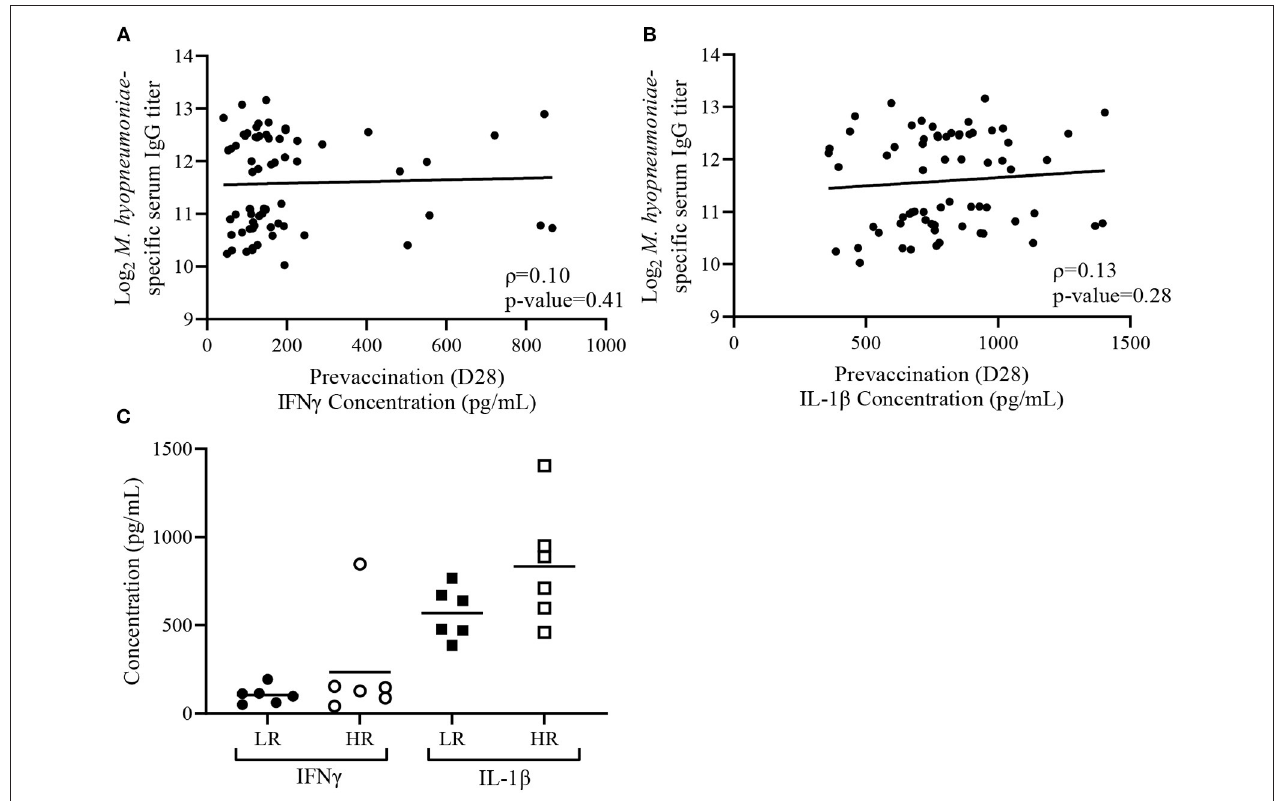
FIGURE 2 | Variability in plasma cytokine concentrations does not associate with Mycoplasma hyopneumoniae -specific IgG responses in the Trial 2020. (A) Spearman correlation analysis of D63 M. hyopneumoniae -specific serum IgG titers with D28 plasma interferon-gamma (IFN γ ) and (B) D28 plasma interleukin 1-beta (IL-1 β ) concentrations from Trial 2020 ( n = 67). Lines represents best-fit lines. (C) Mean plasma concentrations of IFN γ (circles) and IL-1 β (squares) in low (LR; n = 6; closed symbol) and high (HR; n = 6; open symbol) responders from Trial 2020. Differences determined using a Student’s t -test with Welch’s correction.